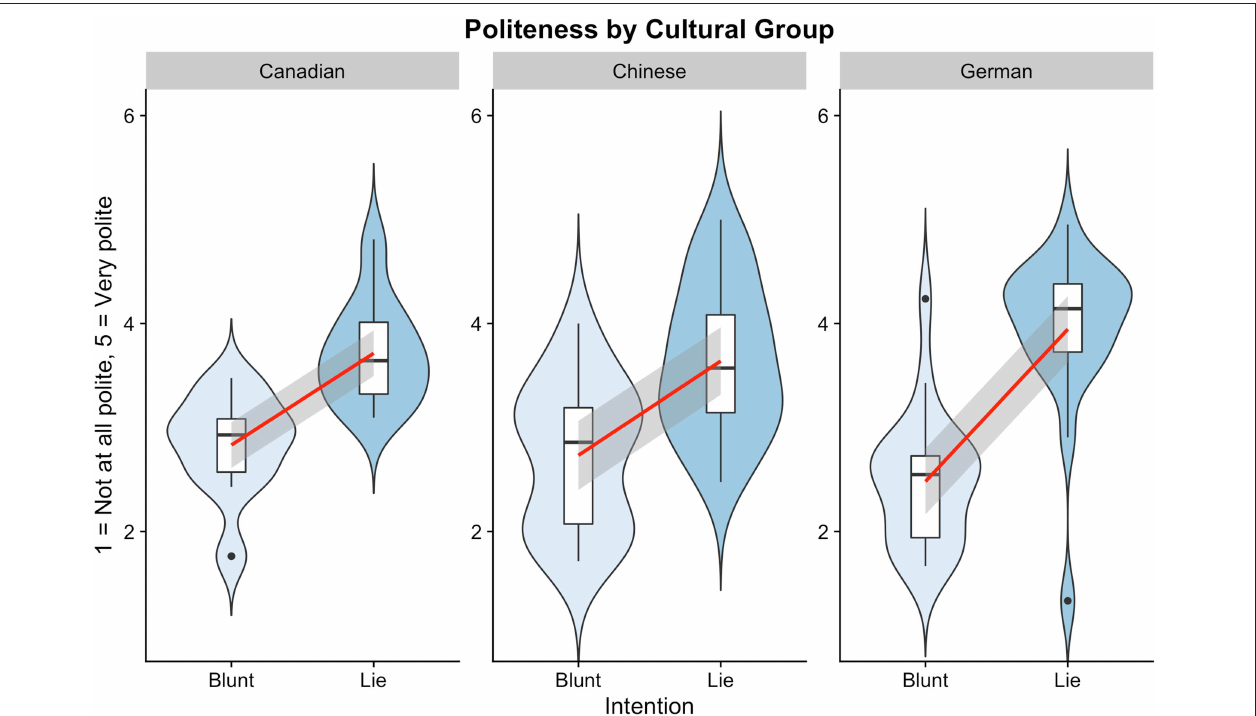
FIGURE 1 | Evaluation of politeness in Canadian, Chinese, and German groups. Violin plots (combining density plots and boxplots) showing Likert scale (1–5) results for politeness by cultural group and intention. The red lines connect the mean values between conditions resulting from a linear model fit while the transparent gray band represents the 95% confidence interval.